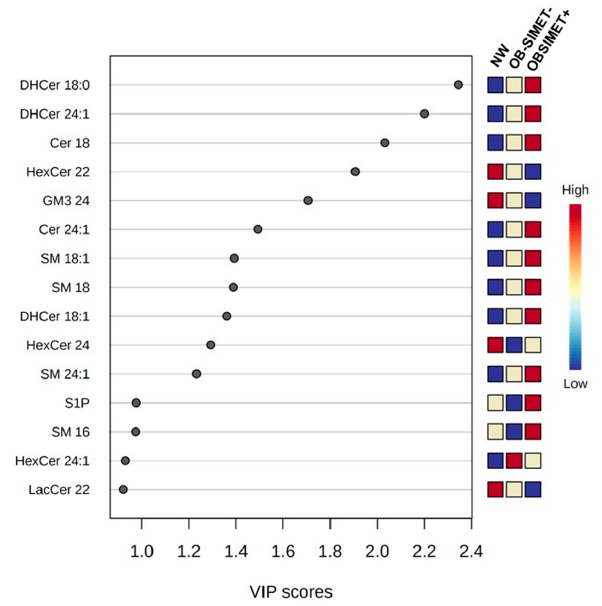
Figure 2. Graphic representation of the discriminating lipids, disclosed by high variance importance in projection (VIP) score, considering a cut-off ≥ 1.0. In Figure 3, discriminant sphingolipids are visualized by heatmaps, evidencing clear- cut di ff erences among NW, OB-SIMET − and OB-SIMET+ subjects. In some sphingolipid families, the di ff erent features showed a consistent pa tt ern, i.e., a general decrease in plasma levels of HexCers, LacCers, and GM3 (with some exceptions), and a general in- crease in plasma levels of DHCers (with some exceptions), and sphingoid bases from lean to obese states. By contrast, the individual Cer species showed an opposite trend, some of them “ in crescendo ” and some of them “ in diminuendo ”.